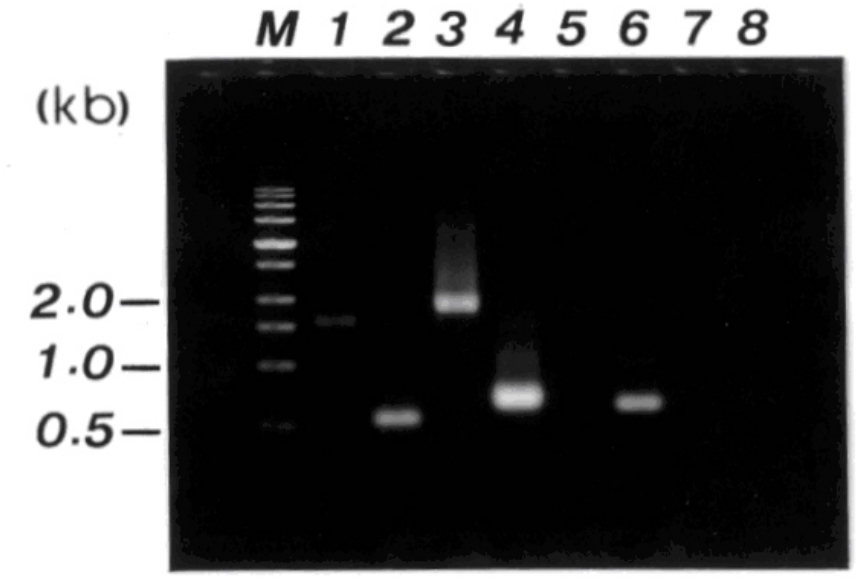
FIGURE 3. PCR analysis and screening of buckwheat species for the major allergenic protein. Two specific primers were used to amplify the full length as well as the region encoding the 22-kDa major allergenic protein of the gene FAGAG1 . Fragments of 1.57 and 0.55 kb were obtained after amplifying the cDNA. The corresponding fragments were 1.8 and 0.7 kb, with genomic DNA of buckwheat, suggesting the presence of introns. M: Molecular size marker, Lanes 1 and 2: cDNA of Fagopyrum esculentum ; Lanes 3 and 4: genomic DNA of F . esculentum ; Lanes 5 and 6: genomic DNA of F . gracilipes ; Lanes 7 and 8: genomic DNA of F. lineare